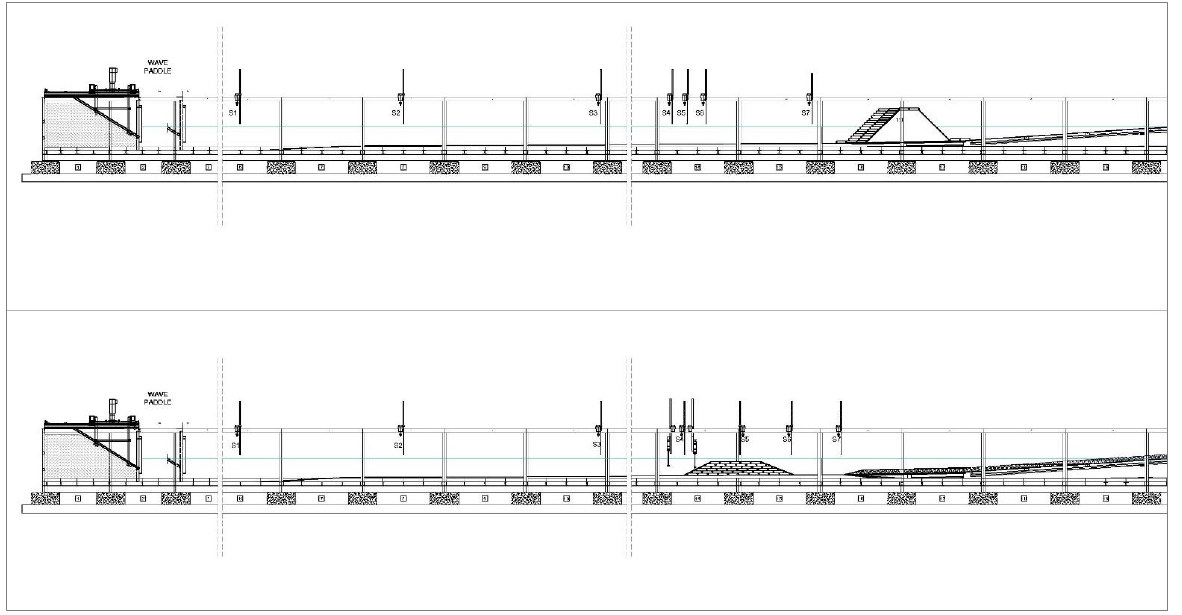
Figure 3. Sketch of the physical models in the wave flume of Dipartimento di Ingegneria Civile, Edile e Architteura, Università Politecnica delle Marche, Ancona (Italy): adherent revetment ( upper panel ) and submerged breakwater ( lower panel